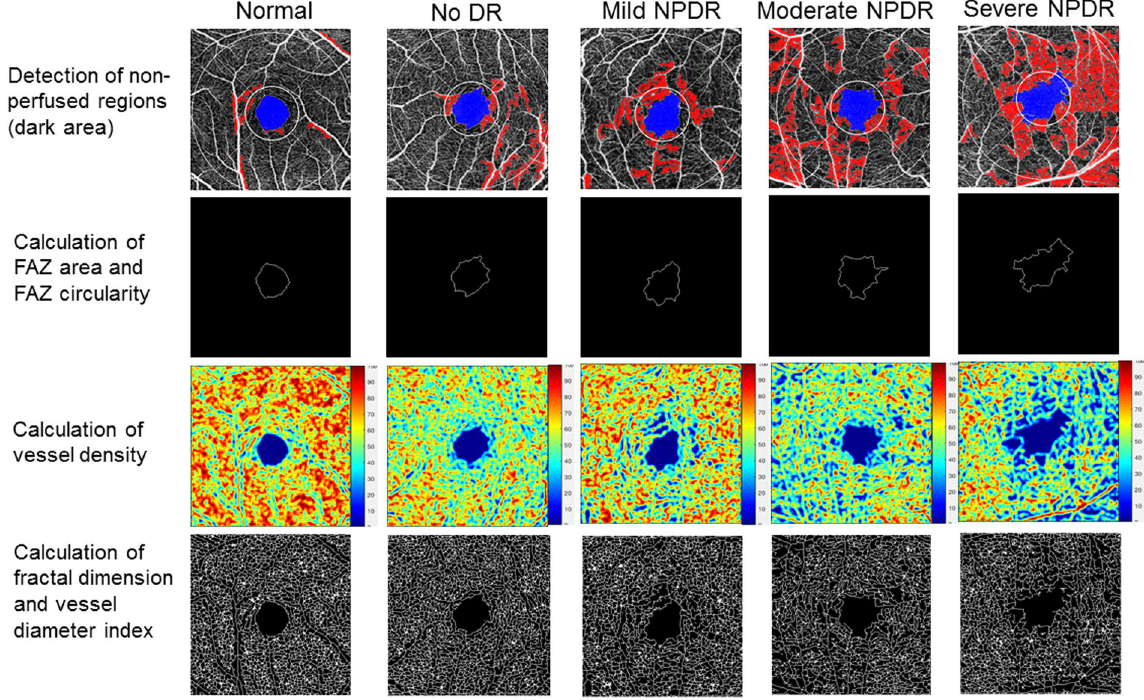
Figure 2. Quantification of retinal capillary network from OCT-angiograms using our customized program in normal and patients with different DR severity. A series of OCT-A metrics including foveal avascular zone (FAZ) area, FAZ circularity, total and parafoveal vessel density, fractal dimension and vessel diameter index can be calculated automatically. The parafoveal region was defined as an annulus with an outer diameter of 3 mm and an inner diameter of 1